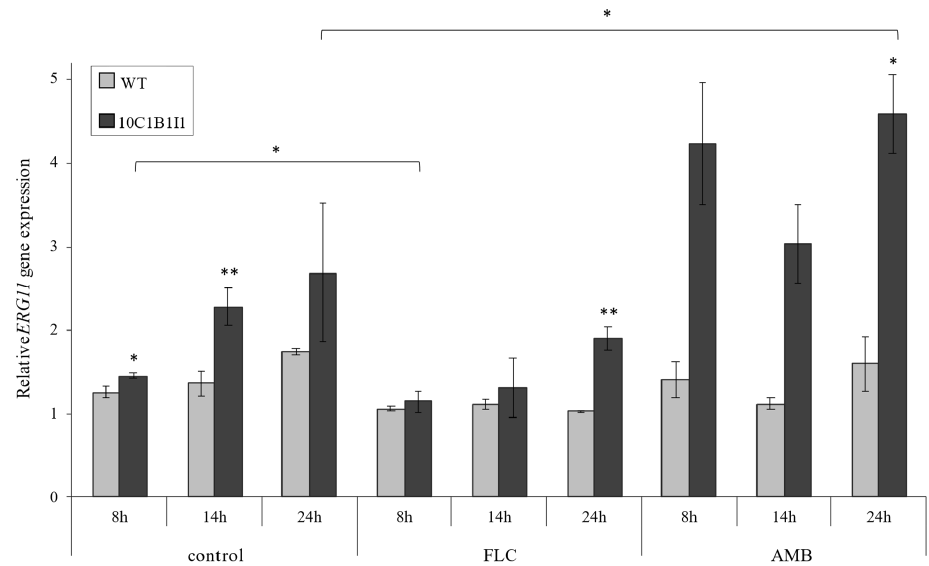
Figure 2. The relative ERG11 gene expression in the C. albicans SC5314 wild type (WT) and ERG11 K143R/K143R (10C1B1I1) strains determined for different growth times (8, 14, and 24 h) and culture conditions: control (YPD medium alone), and with the addition of FLC (4 μ g/mL) or AMB (0.25 μ g/mL); ±SD; n = 3. Statistical analysis was performed by comparing the expression of the C. albicans WT and 10C1B1I1, or between the different culture conditions (*, p < 0.05; **, p < 0.01). Our analysis revealed that the C. albicans 10C1B1I1 strain exhibits an increased ERG11